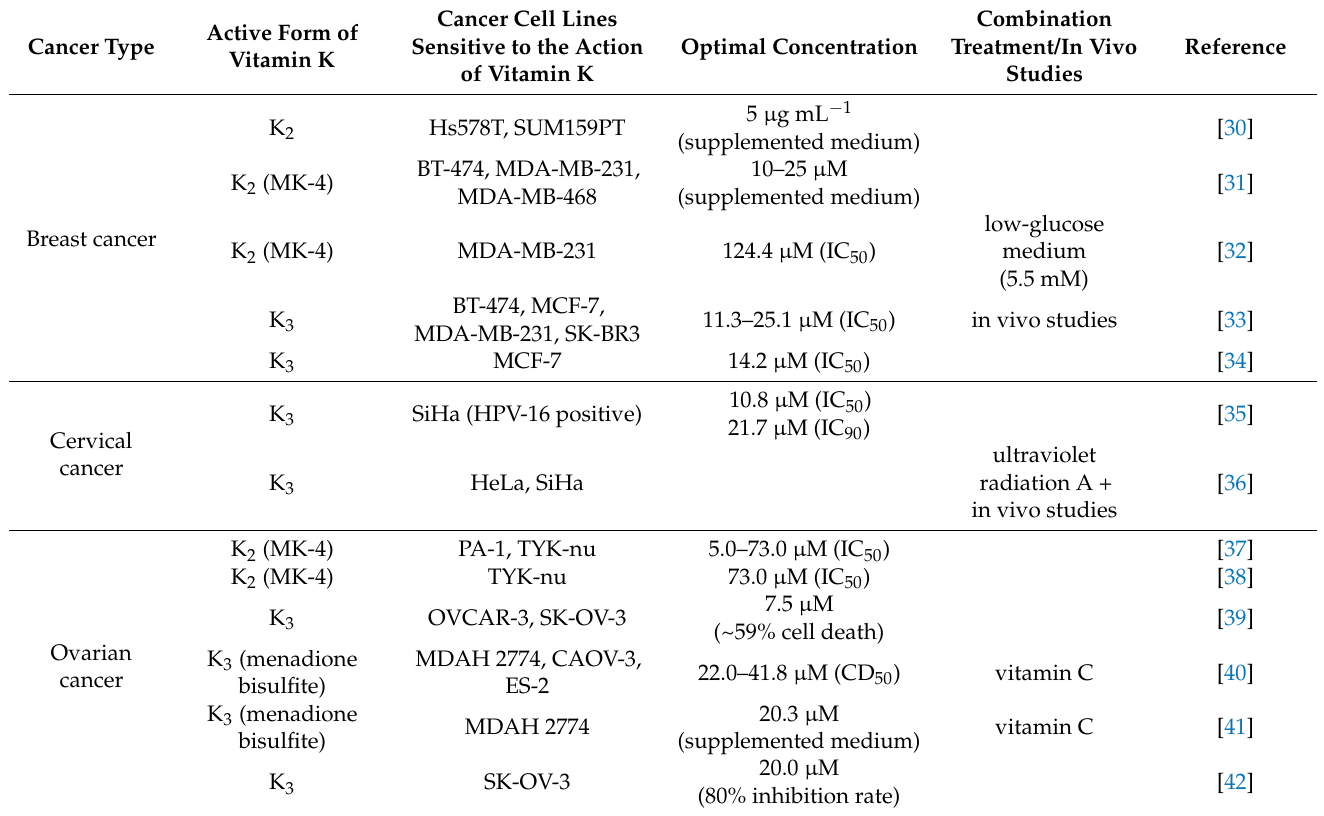
Table 1. In vitro (and animal) studies with vitamin K on cancer cell